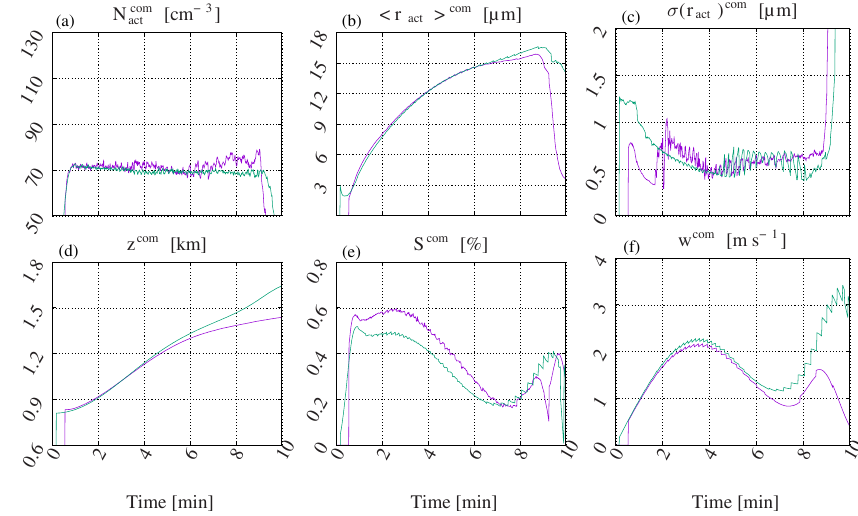
Figure 10. As Fig. 9, but for 4000 super-droplets (UWLCM) or 4000 divisions (Twomey scheme).